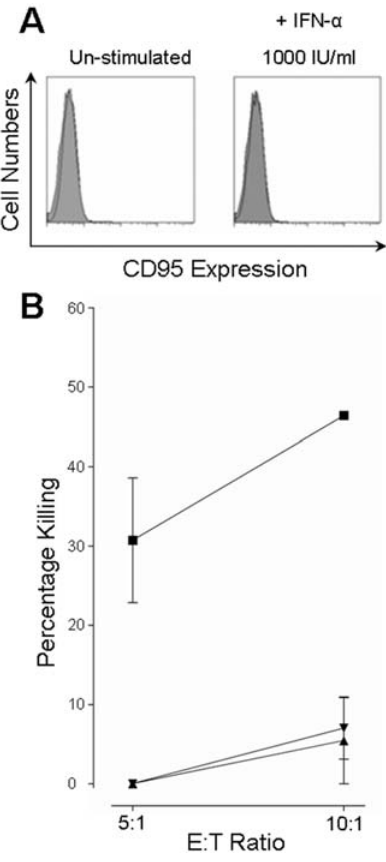
Figure 6. A FAS negative hepatocyte line showed almost complete resistance to CTL killing. A ) The lack of FAS expression on the HHL-16 cells was confirmed by FACS analysis in both un-stimulated and IFN- a stimulated cells. FAS expression was negative under both conditions, mean fluorescence intensity of 4.60 and 4.34 respectively (open curves), and never higher than an isotype control (filled curve). B ) Under normal conditions (closed squares) the HHL-16 cells were able to act as targets for CTL cytotoxicity after 4 hours co-incubation. However, stimulation with IFN- a , either at 100 IU/ml (closed triangles) or at 1000 IU/ml (closed inverted triangle), reduced killing below 10% even at the higher E:T ratio. target cells based on their HLA expression. The HHLs expressed HLA-B35 and therefore lines were generated against the HLA- B35 restricted CMV peptide (IPSINVHHY)–labelled as CTL Line 1. As well as expressing HLA-B35 the HepG2 cell line also